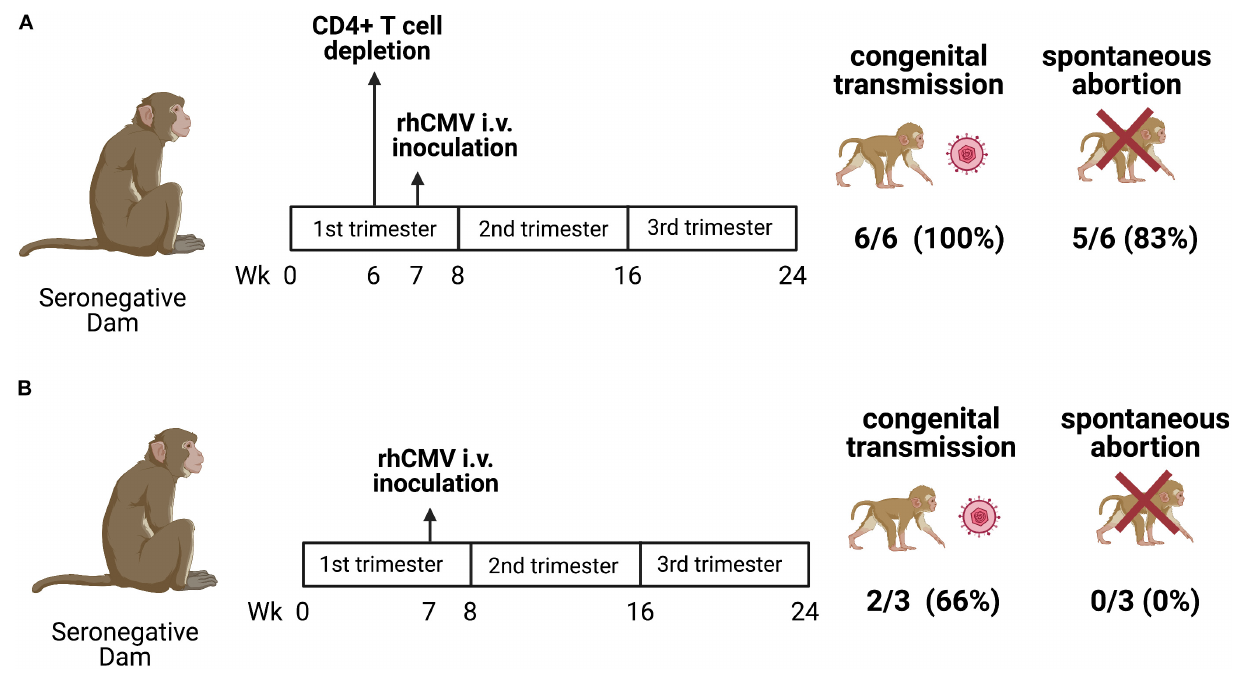
FIGURE 2 | cCMV transmission in a CD4+ T cell-depleted and immunocompetent rhesus macaque ( M. mulatta ) NHP model. (A) Seronegative dams were CD4+ T cell-depleted at gestational week 7 and inoculated with RhCMV 1 week after CD4+ T cell depletion. All (6/6; 100%) dams transmitted RhCMV vertically and a spontaneous abortion occurred in 5 of 6 (83%) dams. (B) Immunocompetent seronegative dams were inoculated with RhCMV at week 7 of pregnancy. Vertical transmission occurred in two of three (66%) pregnancies with no spontaneous abortions (Bialas et al., 2015; Nelson et al.,